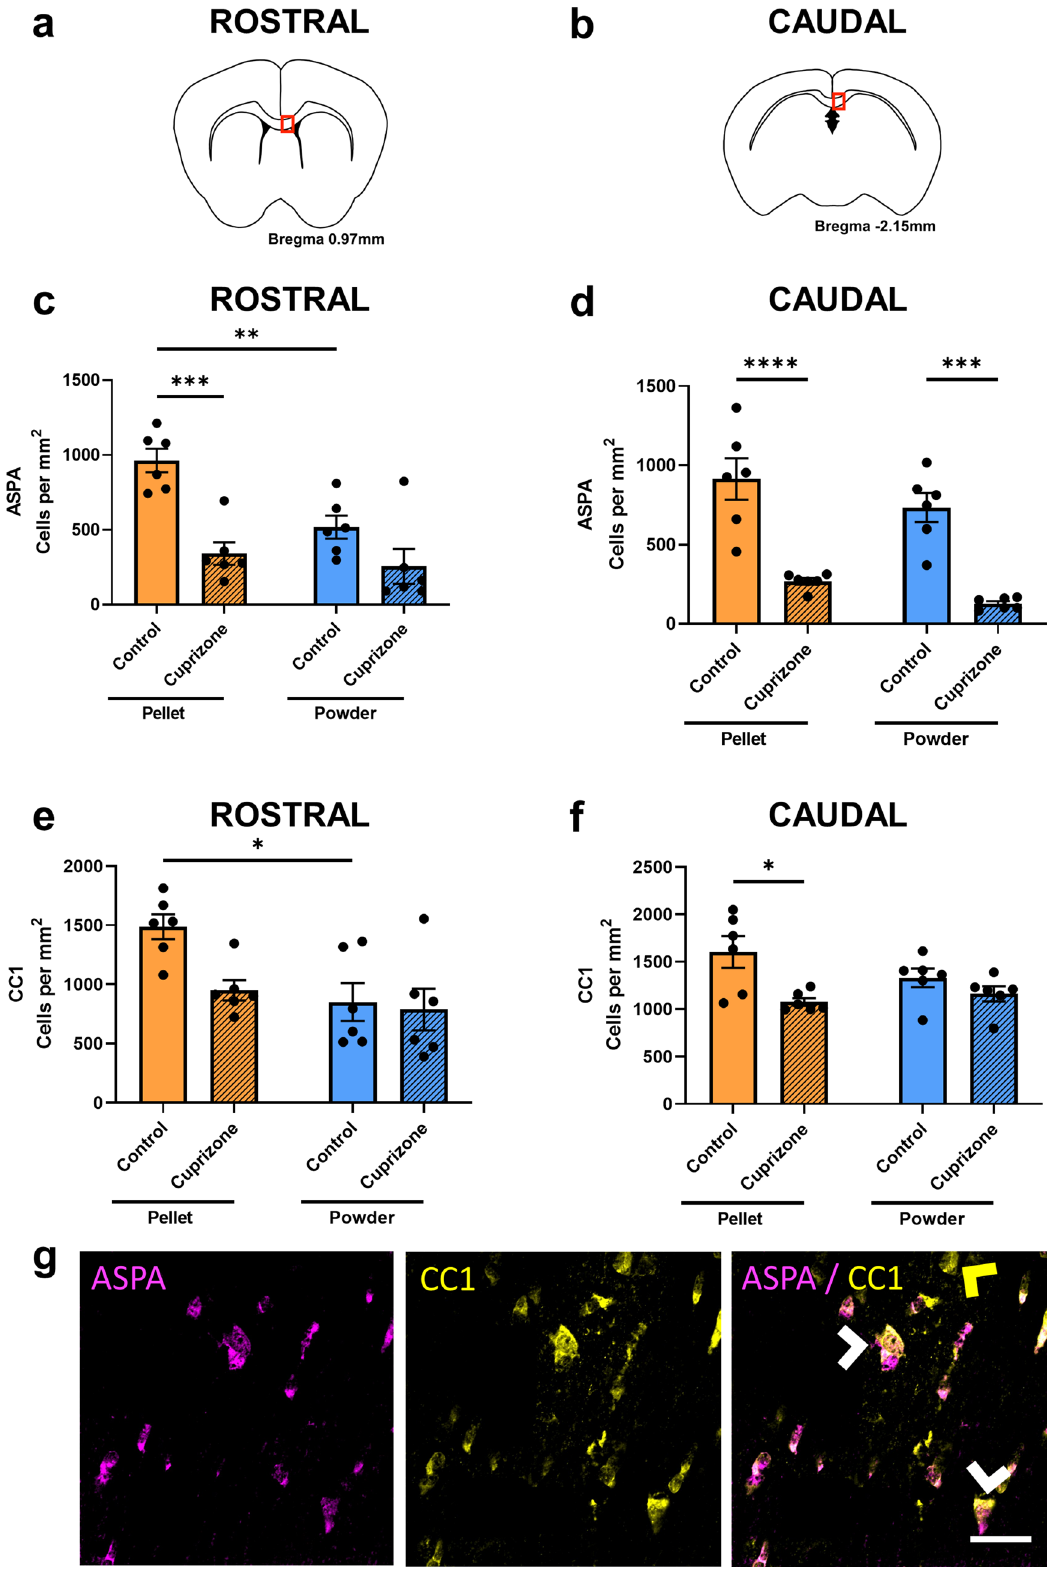
Figure 6. Effects of cuprizone feed formulation on densities of ASPA+ and CC1+ cells. The area of the rostral and caudal corpus callosum analysed is denoted by the red box in the coronal illustrations of the brain ( a , b ). The density of ASPA+ cells ( c , d ) and CC1+ cells ( e , f ) were quantified in the rostral and caudal corpus callosum. N = 6 mice per group, graphs display individual data points overlayed on a bar displaying the mean ± SEM. Significant differences are indicated by *p ≤ 0.05, **p ≤ 0.01, ***p ≤ 0.001, ****p ≤ 0.0001. ( g ) Representative images of ASPA+ and CC1+ cells, indicated with white arrow heads; example ASPA-/CC1+ cell indicated with yellow arrow head; scale bar = 25